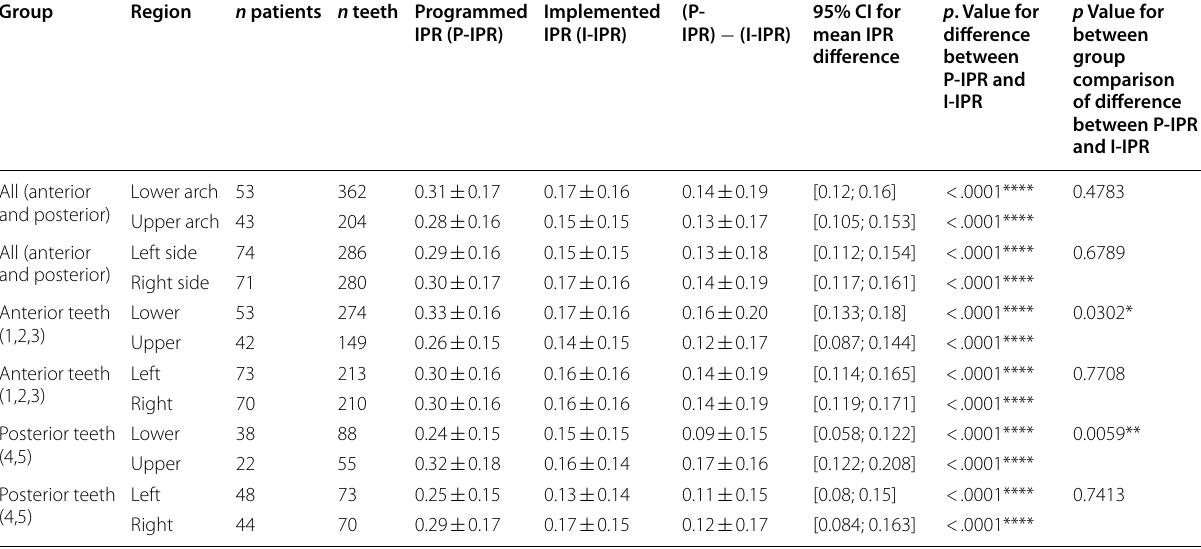
* P < .05; ** P < .01; *** P < .001, **** P <